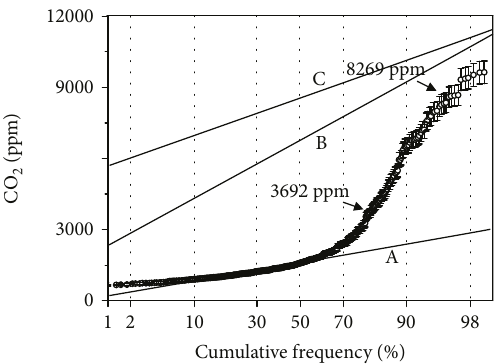
concentrations in the 388 2